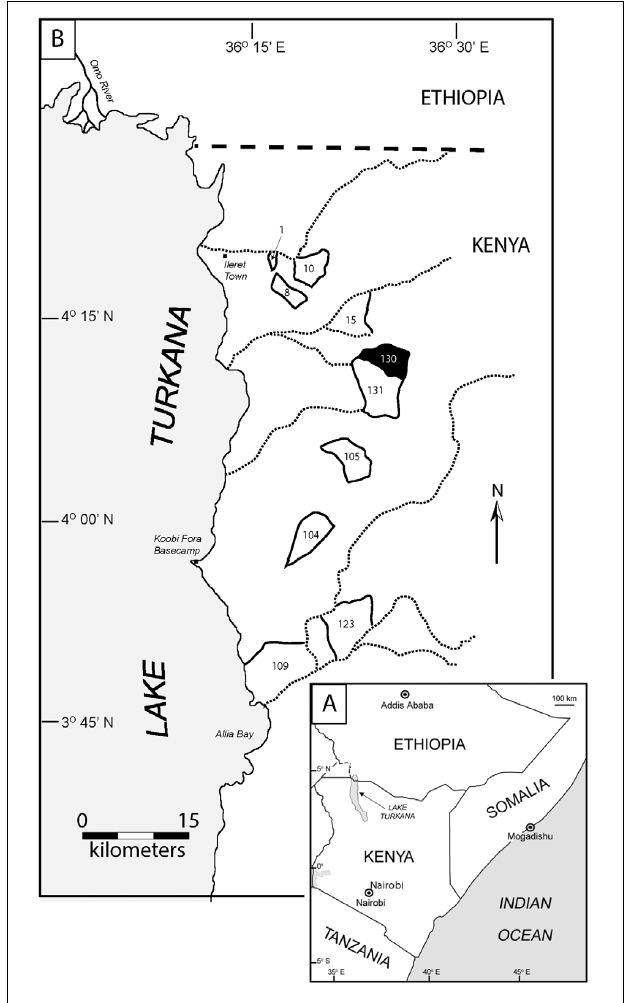
FIGURE 1 | (A) Map of East Africa placing Lake Turkana (northern Kenya) in context. (B) Map of the northeast Turkana Basin showing multiple fossil collection areas of Koobi Fora referred to in this paper. Dotted lines depict the locations of major ephemerals streams. This study focuses on Area 130. Map is modified from Brown and Feibel (1986). Fossil collection area is the name given to a location that has an area of several square kilometers. Multiple fossil sites of hominins and other vertebrates as well as archeological sites are found within these collection areas. The archeological sites range in size from a square meter or two, to tens of square meters. All the fossil and archeological sites discussed in this paper have been previously excavated, mostly during the